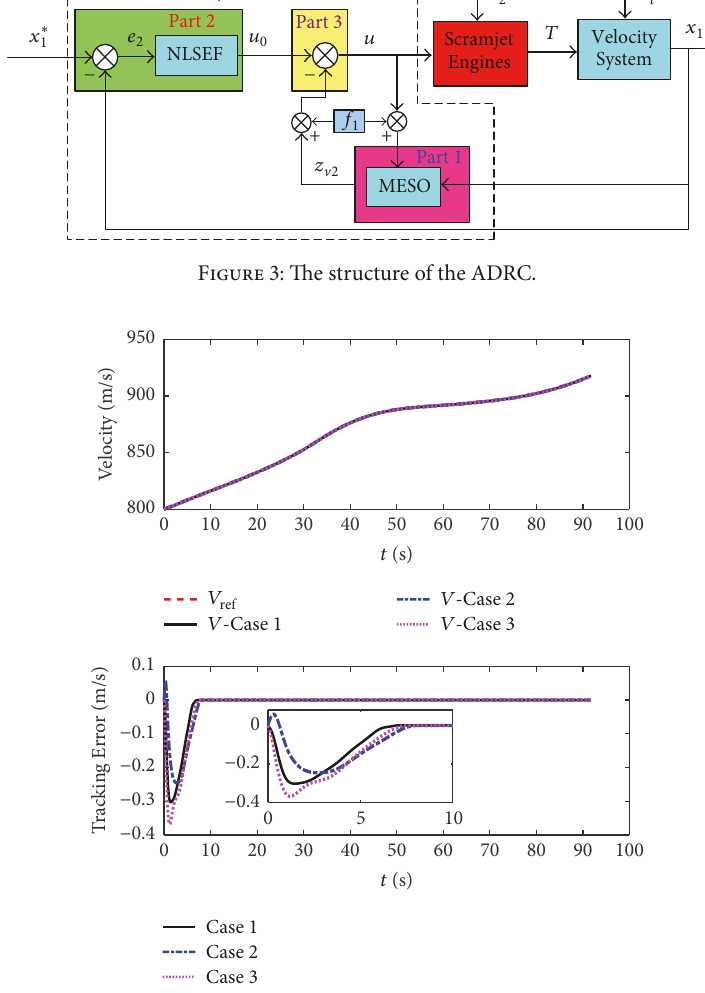
Figure 4: Velocity tracking and tracking error.